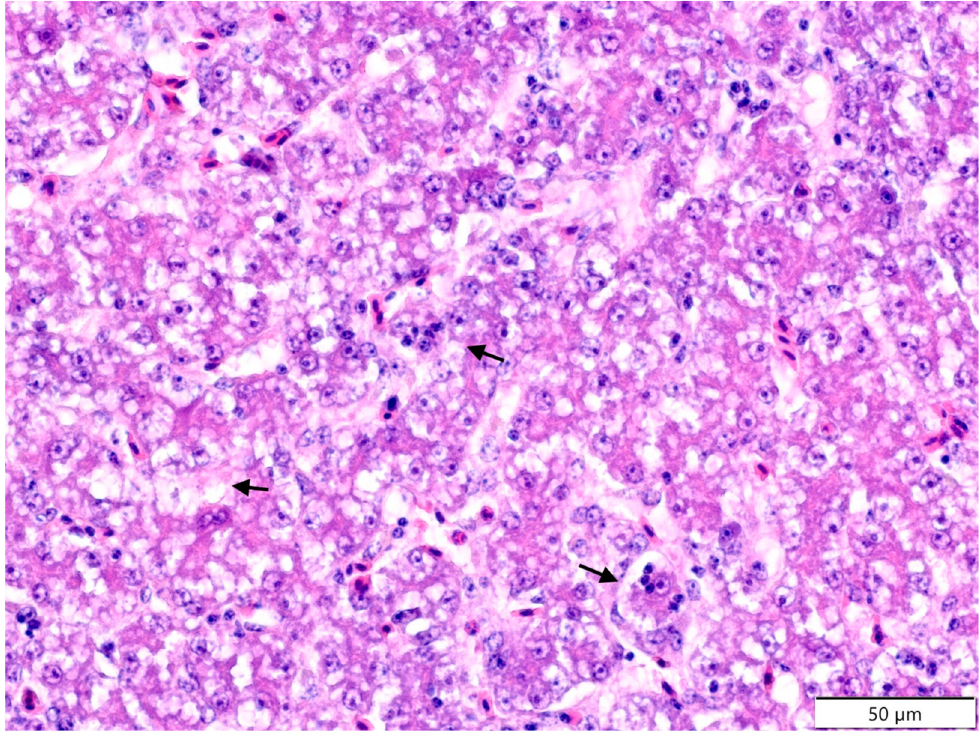
Figure 2. Japanese quail. Liver. CP group. 12th day of experiment. Fatty degeneration of the hepatocytes (black arrows). Detachment of the hepatocytes. Haematoxylin and eosin staining.